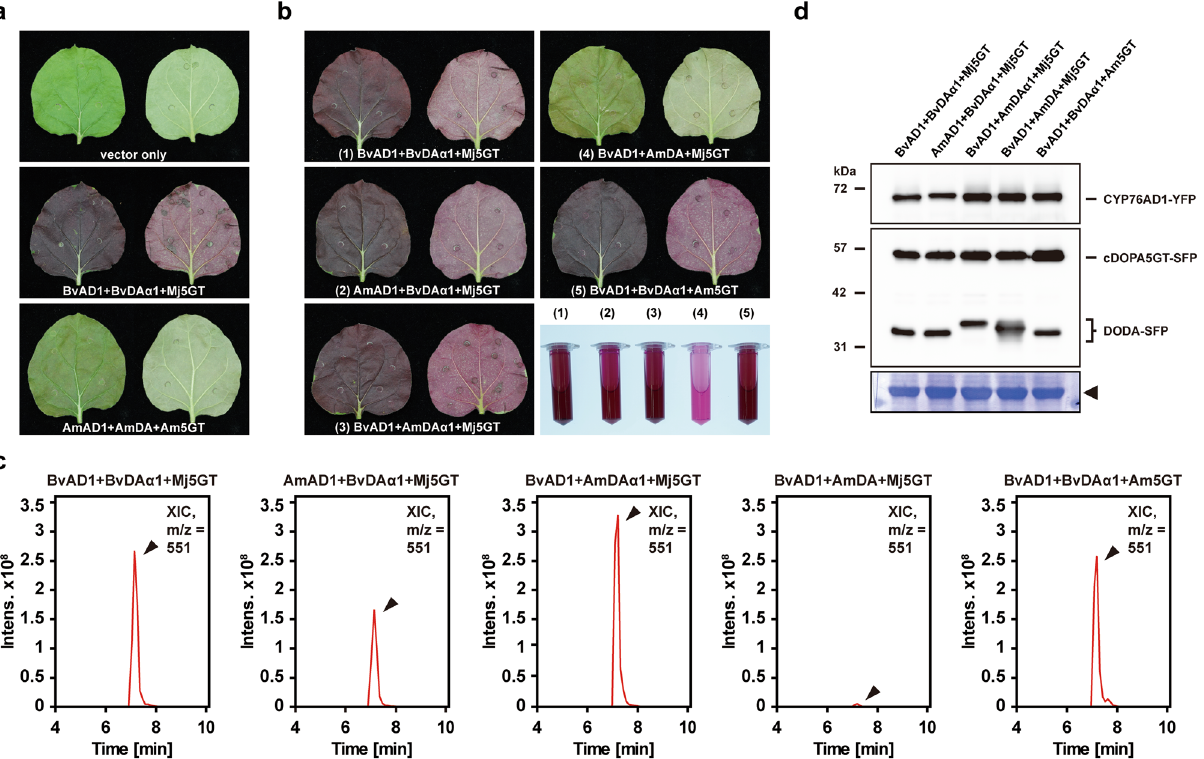
Figure 3. Functional characterization of the enzyme activities of AmCYP76AD1, AmDODA, and AmcDOPA5GT by agroinfiltration for the heterologous engineering of betalain pigments in Nicotiana benthamiana . ( a , b ) N. benthamiana leaves coinfiltrated with Agrobacterium harboring plasmids for the expression of BvCYP76AD1-YFP ( BvAD1 ), BvDODAα1-SFP ( BvDAα1 ), MjcDOPA5GT-SFP ( Mj5GT ), AmCYP76AD1-YFP ( AmAD1 ), AmDODA-SFP ( AmDA ), and AmcDOPA5GT-SFP ( Am5GT ). Both the adaxial (left) and abaxial (right) sides of leaves are presented in each panel. Bottom right corner indicated the betalain pigments produced in N. benthamiana . ( c ) Extracted betalain pigments were examined for betanin content by LC–MS/MS analysis. Shown are XICs of masses corresponding to betanin (m/z = 551). Time, retention time (min). ( d ) Western blotting assays were conducted with antibodies against the YFP- or FLAG (SFP)-tag to examine the expression levels of YFP-tagged CYP76AD1 (upper panel), SFP-tagged DODA (middle panel), and SFP-tagged cDOPA5GT (middle panel). As a loading control, the large subunit of Rubisco visualized by Coomassie brilliant blue staining is indicated by the arrowhead (lower